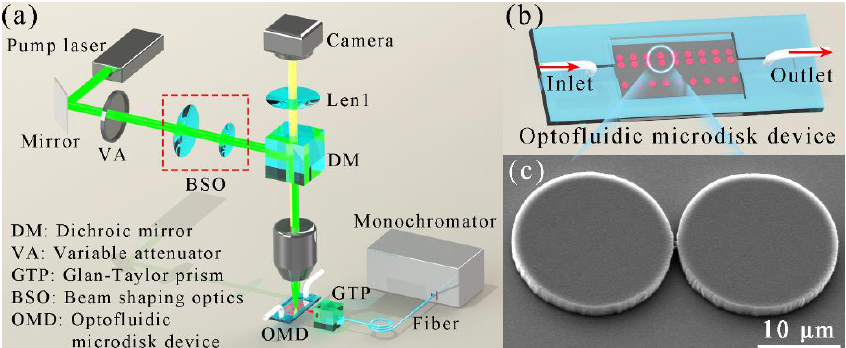
Figure 2. ( a ) Experimental setup schematic of the optofluidic microcavity laser. ( b ) 3-D schematic of the optofluidic microdisk device. ( c ) Scanning electron microscope (SEM) image of typical coupled microdisks. The scale bar is 10 μm.